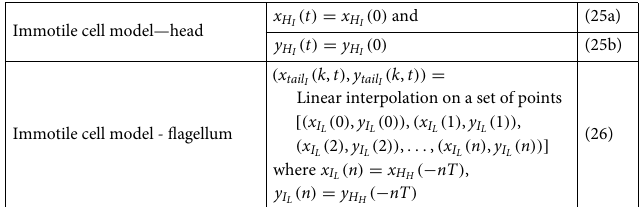
, y H I ) : position of the sperm head of immotile cell. ( x Tail I I